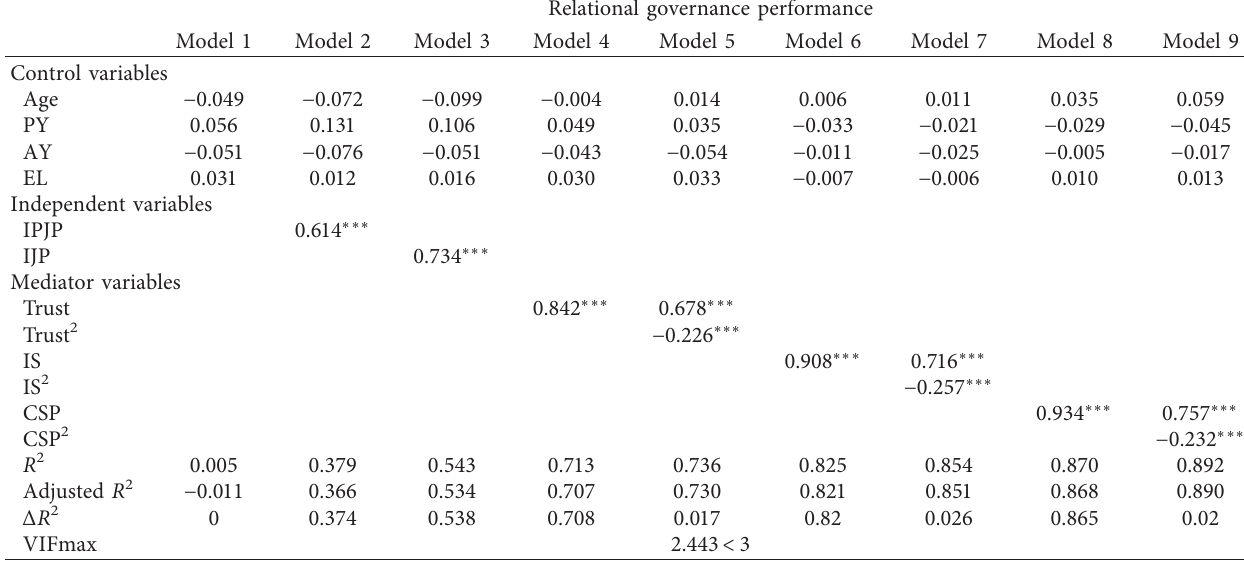
Table 4: Regression analysis results of interactive justice and relational embeddedness on governance